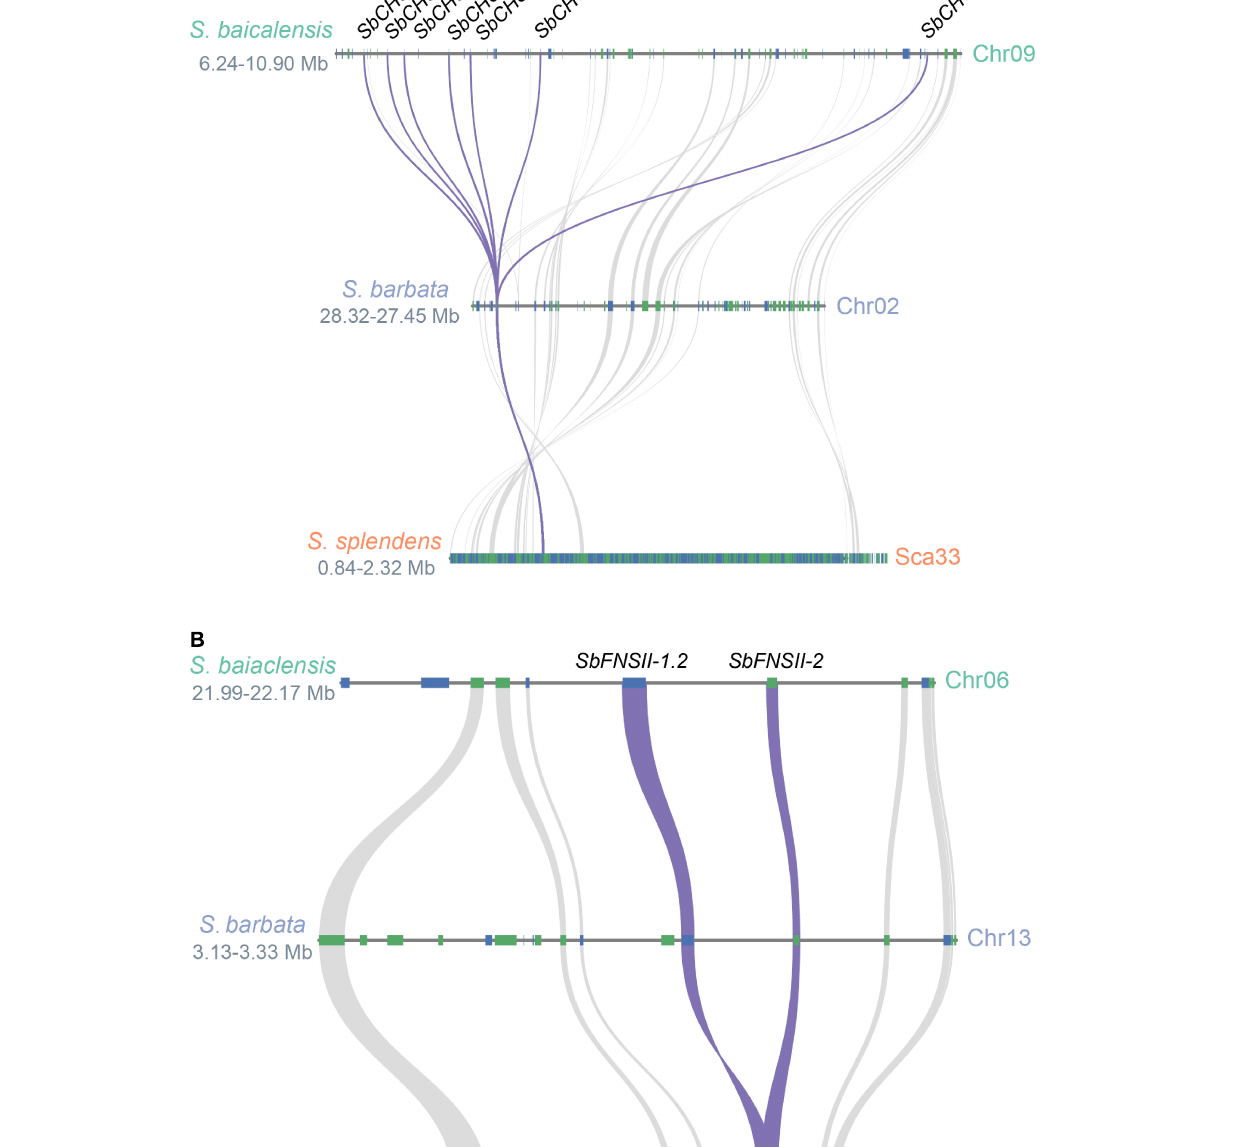
chrysin glycosides in hairy roots. SbF8H (CYP82D2)